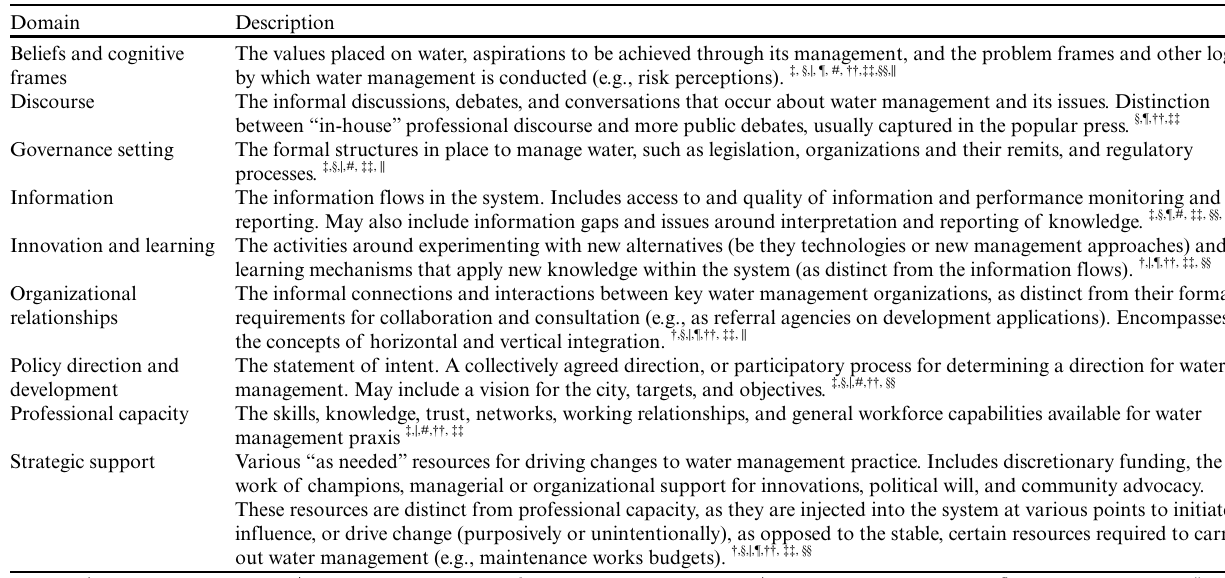
Table 2 . Domains of change within institutional